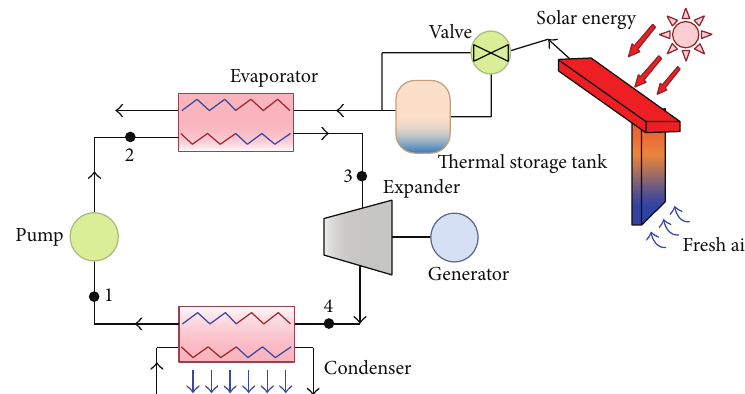
Figure 1: Schematic diagram of the ventilation in building combined with ORC